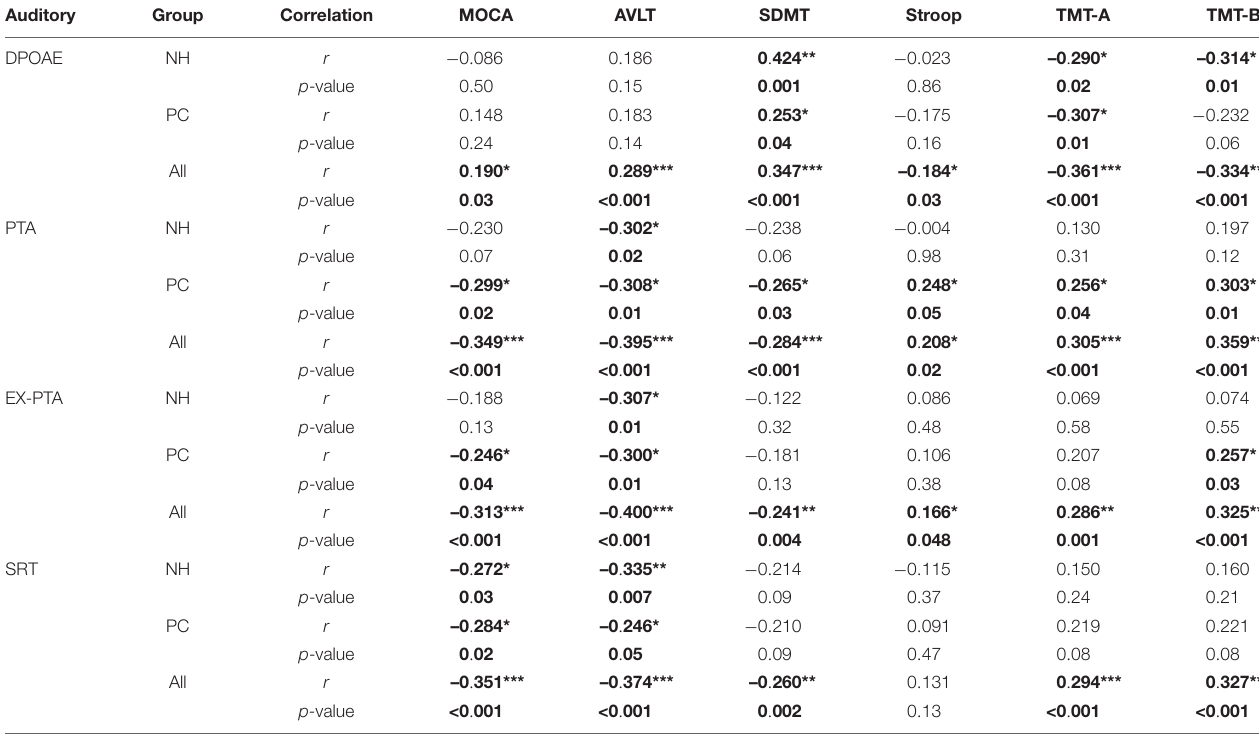
TABLE 2 | The correlation relationship between audiological test and cognitive test. Auditory Group Correlation MOCA AVLT SDMT Stroop